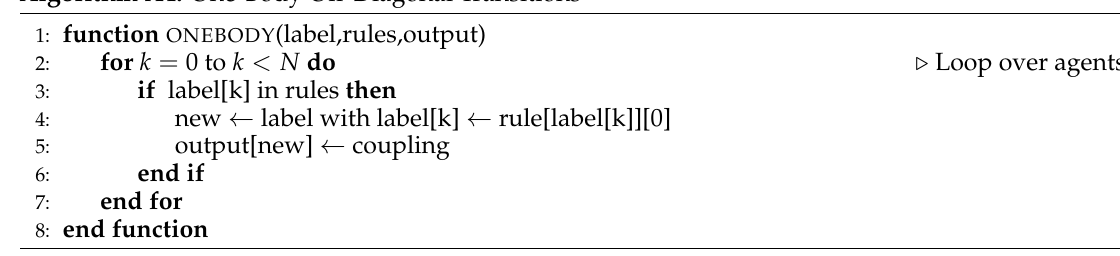
Algorithm A4. One-Body Off-Diagonal Transitions